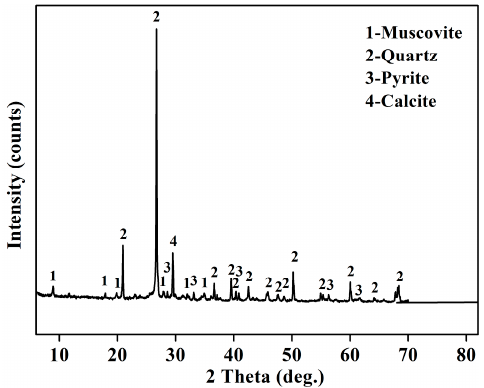
Table 1. Chemical composition of vanadium-bearing shale wt %.